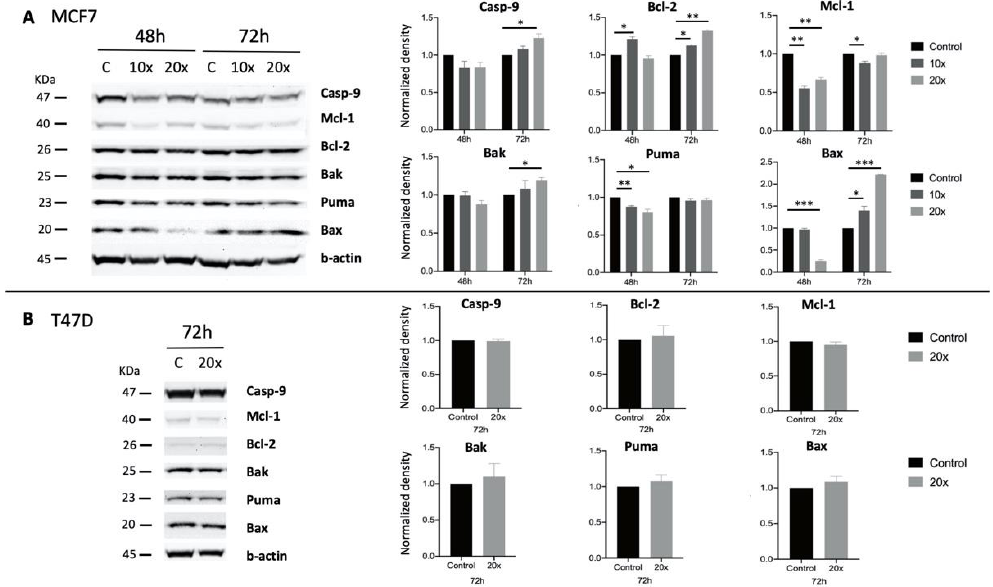
Figure 5. Western blot analysis of apoptotic proteins in methyl-donor treated MCF7 and T47D cell lines. Pro-apoptotic Caspase-9, Bak, and Bax were significantly increased in MCF7 cells after 72h treatments, while the anti-apoptotic Mcl-1 significantly diminished. Interestingly, the pro-apoptotic Puma and the anti-apoptotic Bcl-2 changed significantly in an opposite way as expected ( A ). In the case of T47D, none of the changes were significant ( B ). Each bar represents the average normalized density from at least 3 repeats ± SD. Statistical significance is plotted as *: p < 0.033, **: p < 0.002, or ***: p < 0.001. C: control; Casp-9: Caspase-9. ×10 and ×20: concentrations of methyl-donors.